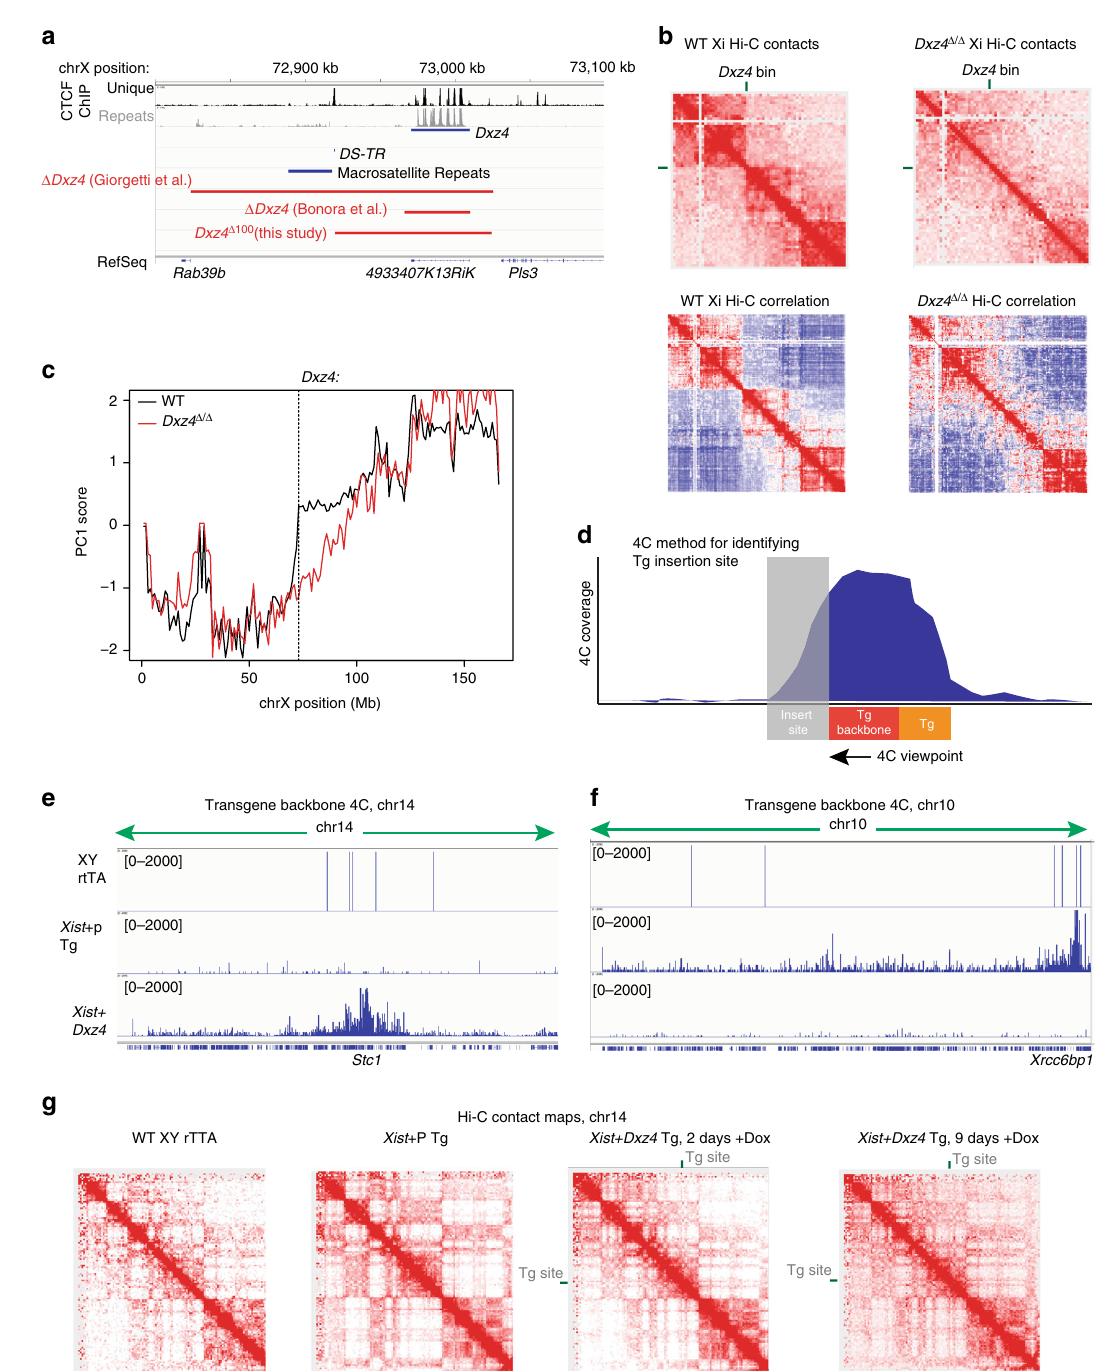
Fig. 3 Dxz4 is necessary but not suf fi cient for megadomain formation. a Schematic of prominent features in the Dxz4 region and deletions generated in this study and previous studies. b Top: Contact maps for the Xi at 2.5 Mb resolution for wild-type (left) and Dxz4 Δ / Δ (right) cells on d10 of differentiation. Bottom: Pearson correlation matrices at 1 Mb resolution for the wild-type (left) and Dxz4 Δ / Δ Xi (right). Heatmaps generated by merging reads together from two biological replicates. c 1st principal component of the 1 Mb correlation matrix plotted for wild-type (black) and Dxz4 Δ / Δ (red) across all bins on the Xi. The dotted line corresponds to the bin containing Dxz4 . d Strategy for using 4C to localize the transgene insertion site. e , f 4C interaction pro fi les using a viewpoint in the backbone of an Xist transgene in either wild-type (top), Xist only Tg (middle) or Xist + Dxz4 Tg (bottom) lines across chr14 ( e ) or chr10 ( f ). g Hi-C contact maps for chr14 at 1 Mb resolution in either wild-type (left), Xist only Tg (middle left), Xist + Dxz4 Tg Dox induced for 2 days (middle right) or 9 days (right). The position of the Xist + Dxz4 transgene insertion site at ~69.8 Mb (near Stc1 ) is indicated by a green bar in the Xist + Dxz4 Tg contact